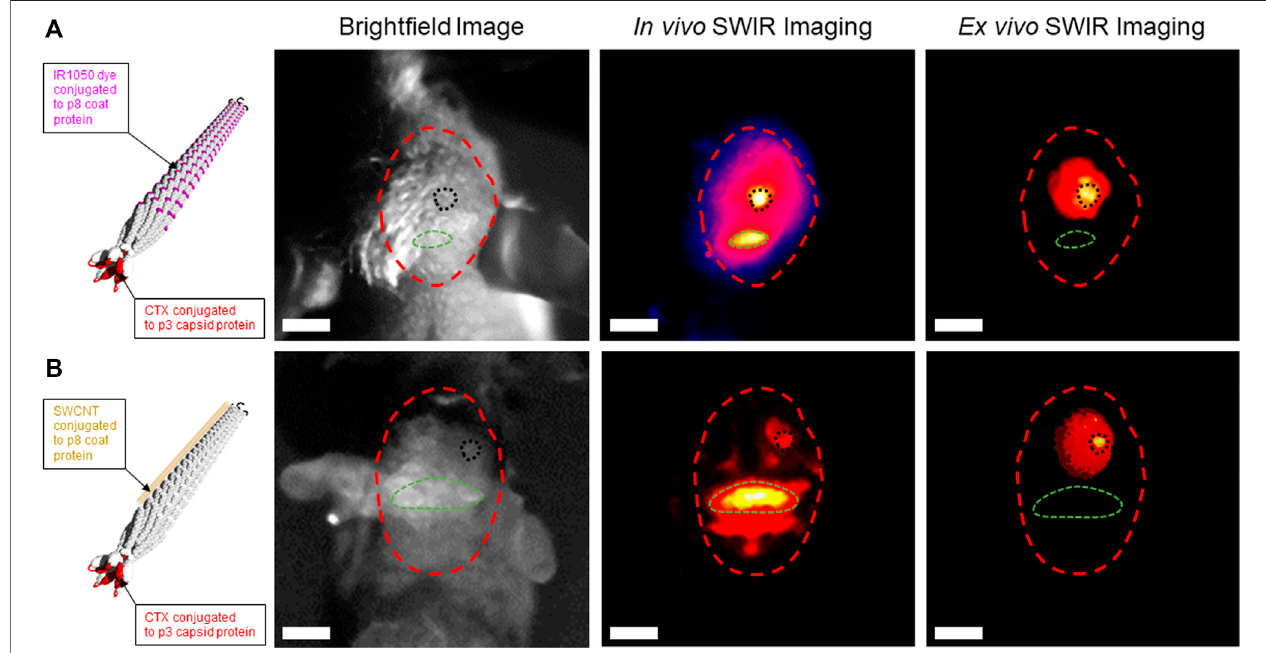
FIGURE 1 | Chlorotoxin (CTX)-functionalized M13 phage conjugated to IR1050 dye or single-wall carbon nanotubes (SWCNT) detect GBM22 human glioma tumorsusingshort-wavelengthnearinfraredII(SWIR)imaginginanintracranialorthotopicxenograftmodelofhumanglioblastoma. (A) Leftpanel — schematicofIR1050- CTX-M13 phage. Right panels — bright fi eld image of the skull of a GBM22 mouse (red dotted circle). In vivo SWIR imaging through the skull localizes IR1050-CTX-M13 phage signal at the site of a GBM22 tumor in the right frontal hemisphere (black dotted circle). Background SWIR signal caused by uptake of IR1050-CTX-M13 phage in the occipital bone (green dotted circle). Ex vivo SWIR imaging shows uptake of IR1050-CTX-M13 phage in a GBM22 tumor in the mouse brain. (B) Left panel — schematicofSWCNT-CTX-M13phage. Rightpanels — bright fi eldimageoftheskullofaGBM22mouse(reddottedcircle). Invivo SWIRimagingthroughtheskull localizes SWCNT-CTX-M13 phage signal at the site of a GBM22 tumor (black dotted circle). Background SWIR signal caused by uptake of SWNT-CTX-M13 phage in the occipital bone (green dotted circle). Ex vivo SWIR imaging shows uptake of SWCNT-CTX-M13 phage in a GBM22 tumor. White scale bar = 1